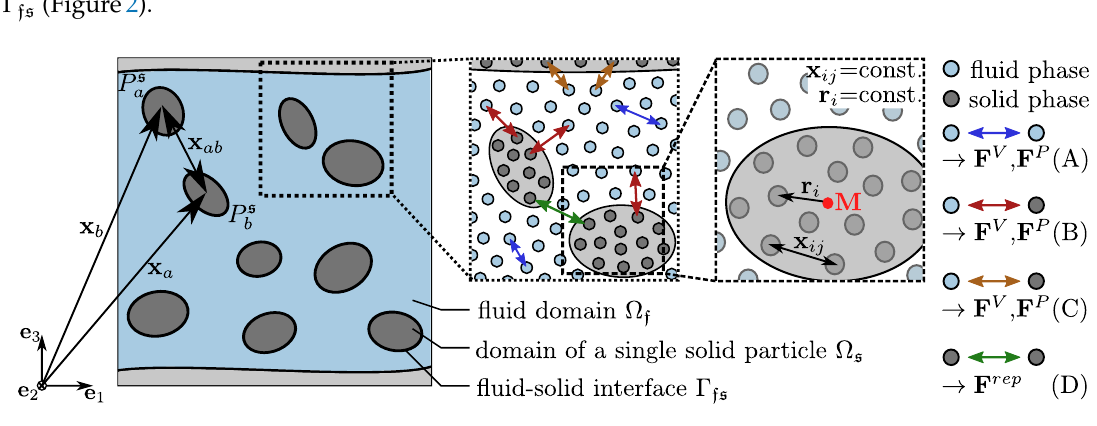
Figure 2. Discretization of the fluid (blue) and solid (dark grey) phase using Smoothed Particle Hydrodynamic (SPH) particles and occurring short-range particle interaction forces related to the four introduced cases